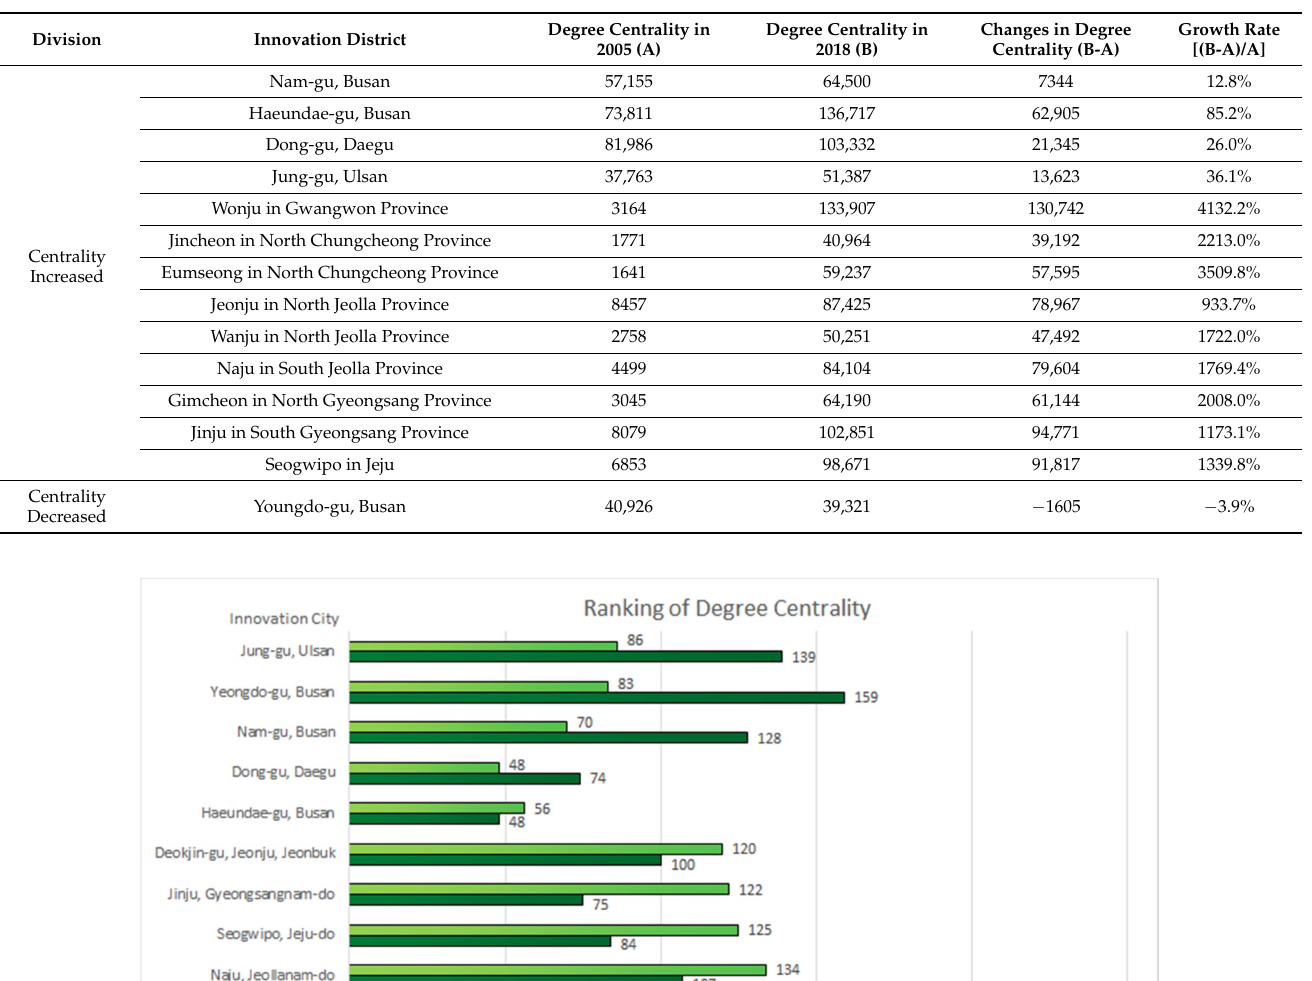
Table 4. Changes in degree centrality of Innovation Cities.